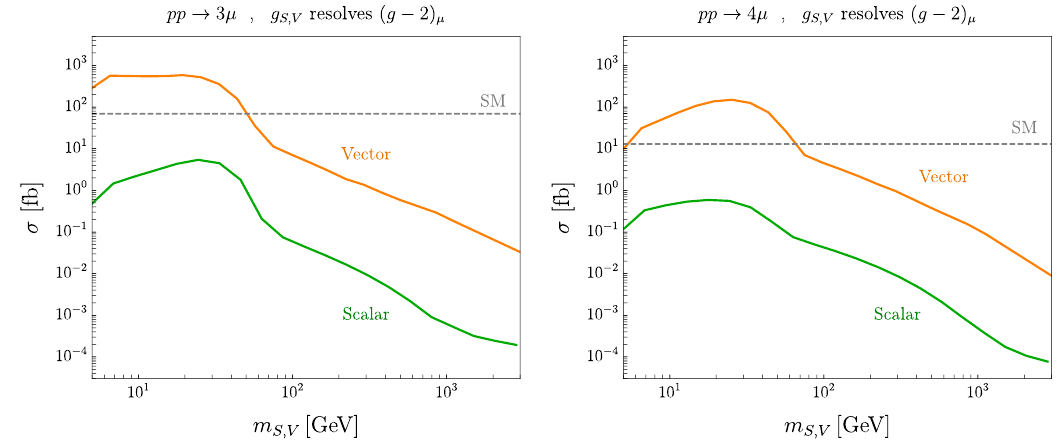
Figure 7 . LHC production cross sections for scalar and vector singlets in pp → 3 µ (left) and pp → 4 µ (right) final states that include S/V → µ + µ − contributions assuming 100% branching √ ratios to di-muons. In all cases we assume s = 13 TeV and the singlet couplings are chosen to resolve the ( g − 2) anomaly as shown in figure 2. The dashed gray line in each plot corresponds to µ the SM background prediction in each